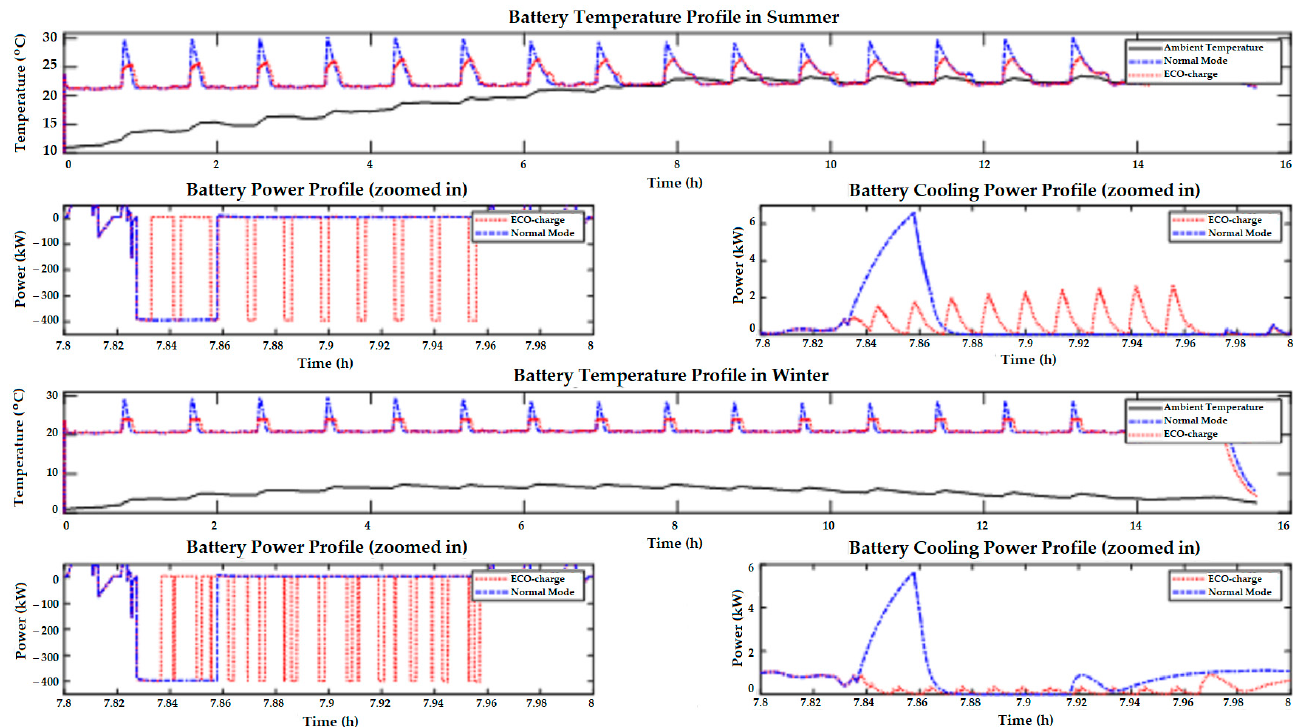
Figure A6. ECO ‐ charging profile highlighting the effects of pulsed charging functionality. Figure A6. ECO-charging profile highlighting the effects of pulsed charging